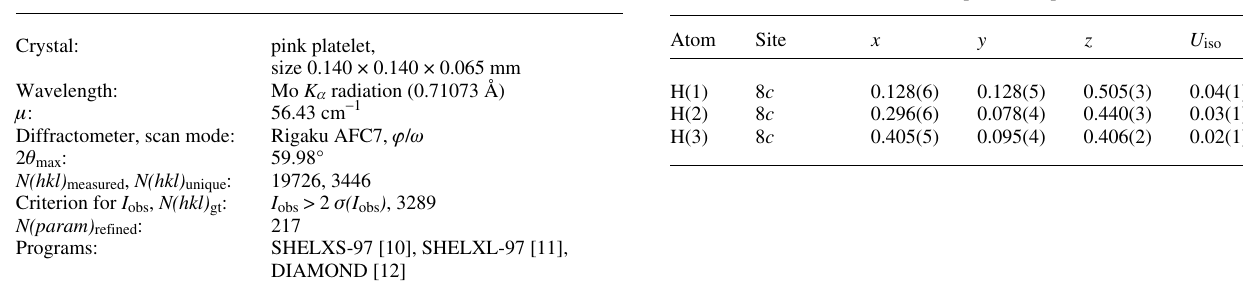
Table 2. Atomic coordinates and displacement parameters (in Å 2 ) . Table 1. Data collection and